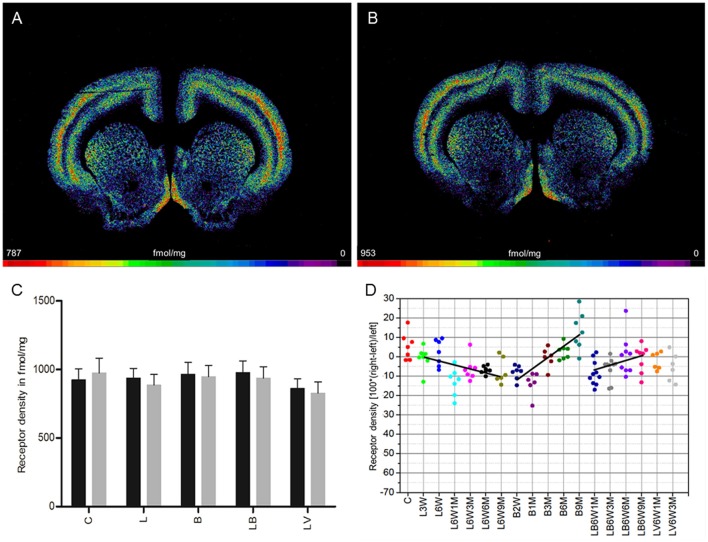
(A,B) Contrast-enhanced color-coded images showing the regional distribution of M2 receptor density labeled with the agonist [3H]oxotremorine-M in a control rat (A,B) after 6-OHDA lesion (group L6W1M) in a control rat (A) and after 6-OHDA lesion (group L6W1M) (B). (C) Mean receptor density (fmol/mg protein; averaged over all post-lesion survival times) in the left/contralateral (black column) and right/ipsilateral hemispheres (gray column) of the 5 groups (see Figure 1). All data is expressed as means ± SD. (D) Scatter plots and regression analyses of the right-left differences of M2 receptor density for all 18 groups and time points (five groups with different survival times); see Table 1 for explanation of abbreviations. Significant regressions are labeled by a continuous line.